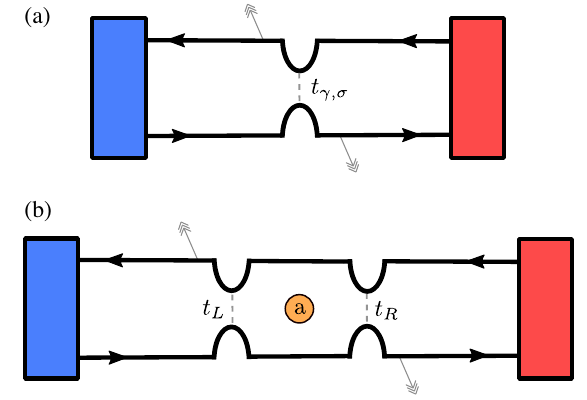
FIG. 4. (a) Single-pinch and (b) double-pinch geometries for a chiral spin liquid heated from the right and cooled from the left. In the double-pinch geometry, we allow for a bulk quasiparticle of type “ a ” inside the enclosed region. We imagine measuring the heat current immediately after the pinch point(s), at the locations marked with light gray